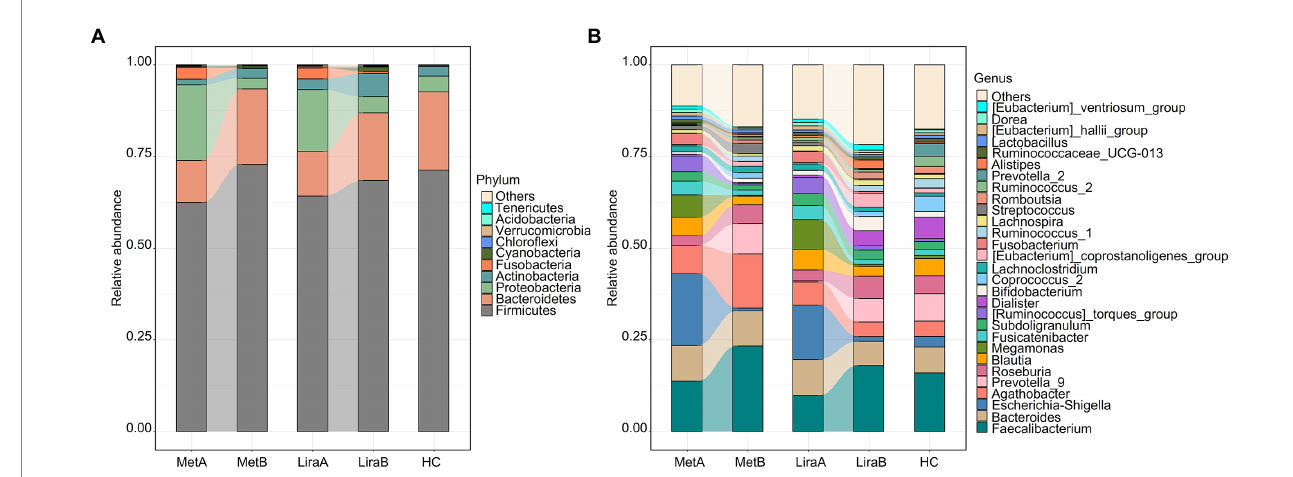
FIGURE 2 (A) Differences in the intestinal bacterial community structure (phylum level) between healthy controls and patients before and after metformin or liraglutide treatment. (B) Differences in the intestinal bacterial community structure at the genus level between healthy controls and patients before and after metformin or liraglutide